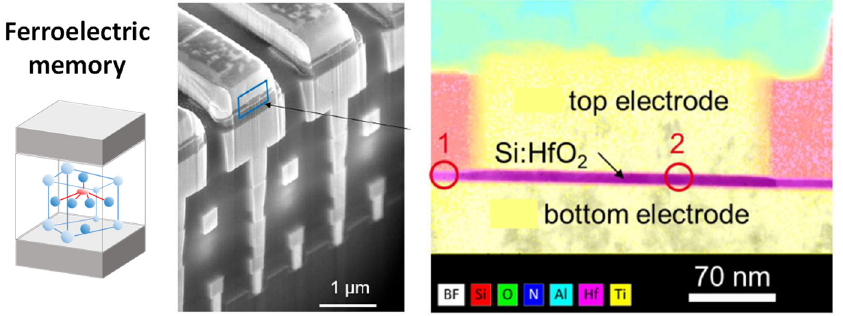
Figure 5. SEM and TEM cross sections of ferroelectric TiN/10 nm Si(1%)-implanted HfO 2 /TiN capacitors integrated between M4 and M5 of a 130 nm CMOS, from [91].